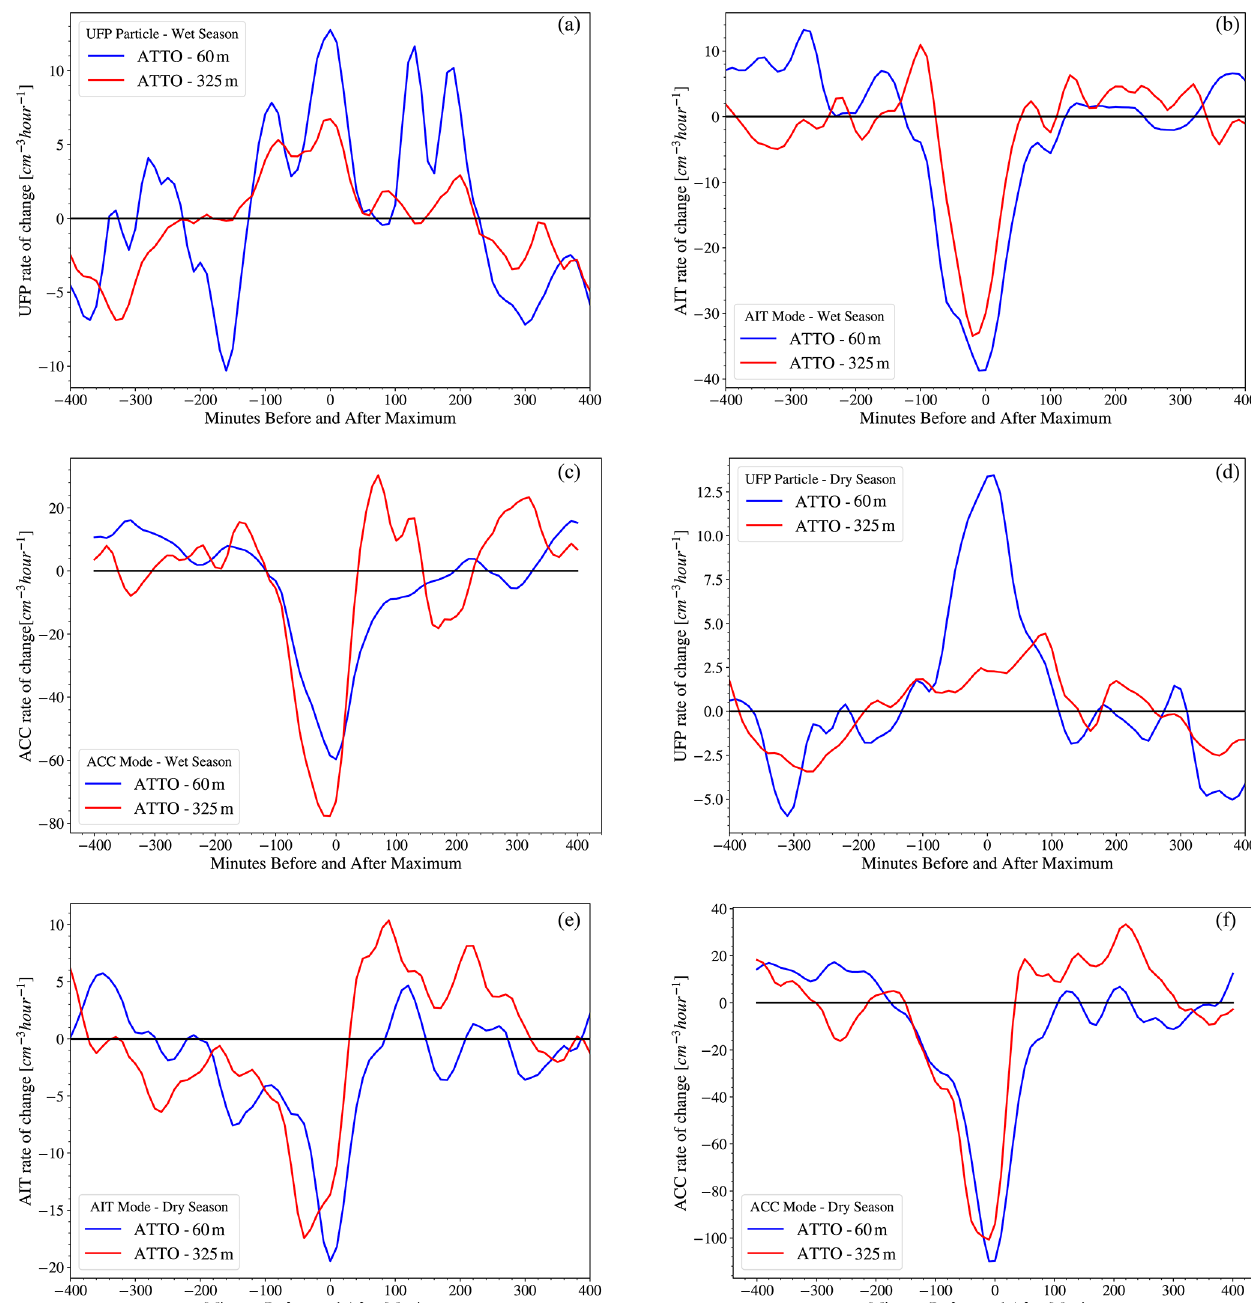
Figure 9. Rate of change in number concentrations from 400min before to 400min after the maximum lightning density (0.65 quartile) for (a) N UFP at 60 and 325m during the wet season, (b) N AIT at 60 and 325m during the wet season, (c) N ACC at 60 and 325m during the wet season, (d) N UFP at 60 and 325m during the dry season, (e) N AIT at 60 and 325m during the dry season, and (f) N ACC at 60 and 325m during the dry